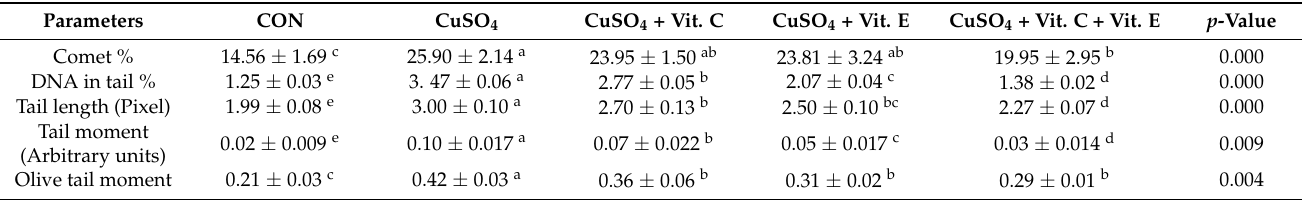
Table 8. Effect of single or combined supplementation of vitamin C and E on the DNA degradation indices in broiler chickens at the end of the 6th week (Mean ± SD).